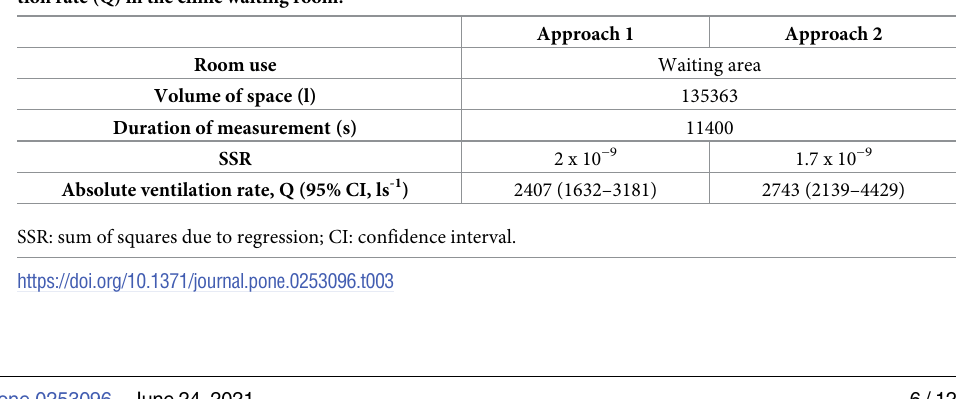
Table 3. Results of approach 1 (linear regression) and approach 2 (model fit) for estimating the absolute ventila- tion rate (Q) in the clinic waiting